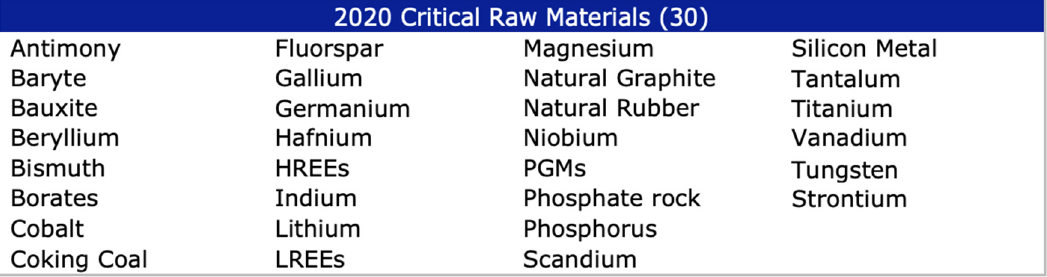
Figure 1. The 2020 List of Critical Raw Material [2].